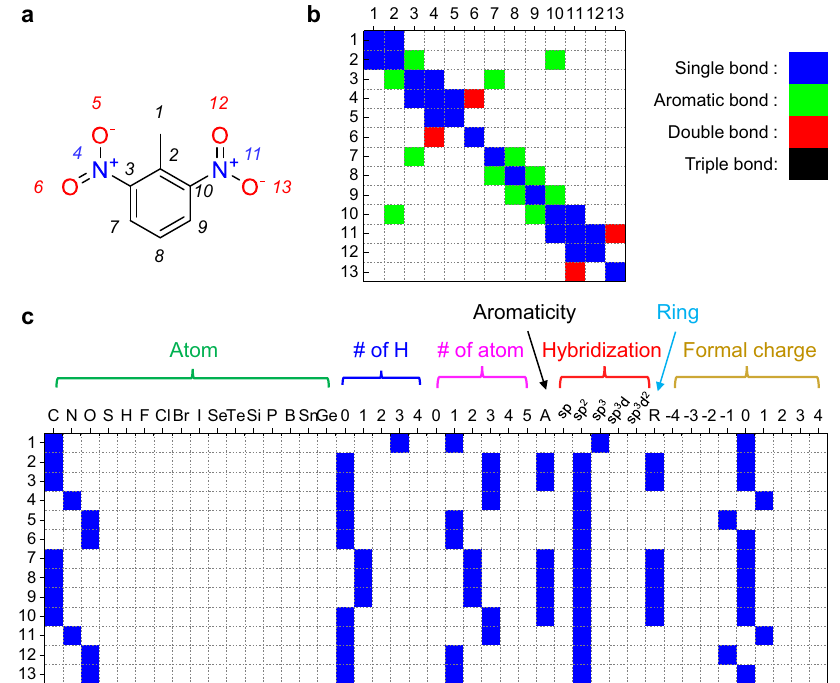
Fig. 6 Graph representation of a molecule. a Molecular structure. b adjacency matrix ( A j ), and c feature matrix ( X j ) of